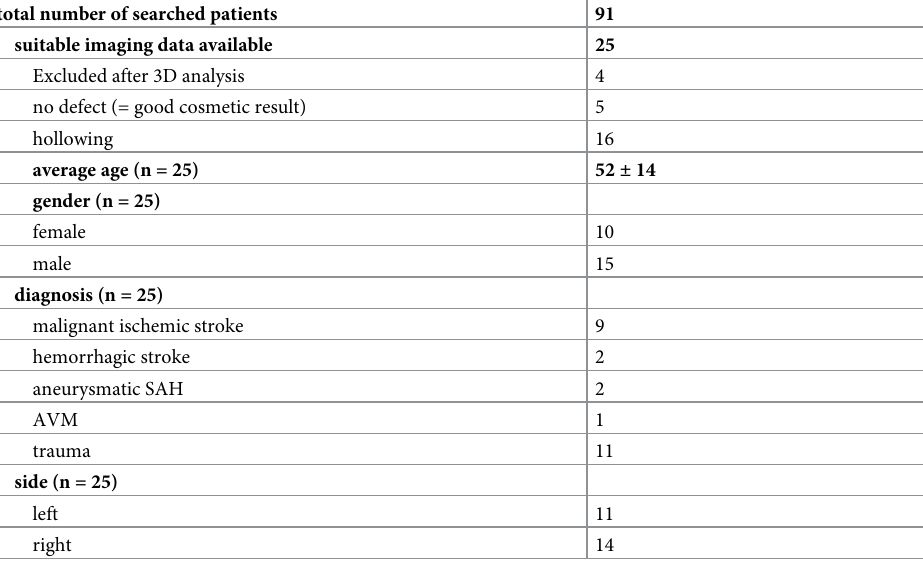
Table 1. Demographic data of patients and diagnosis requiring their respective craniectomies. total number of searched patients 91 suitable imaging data available